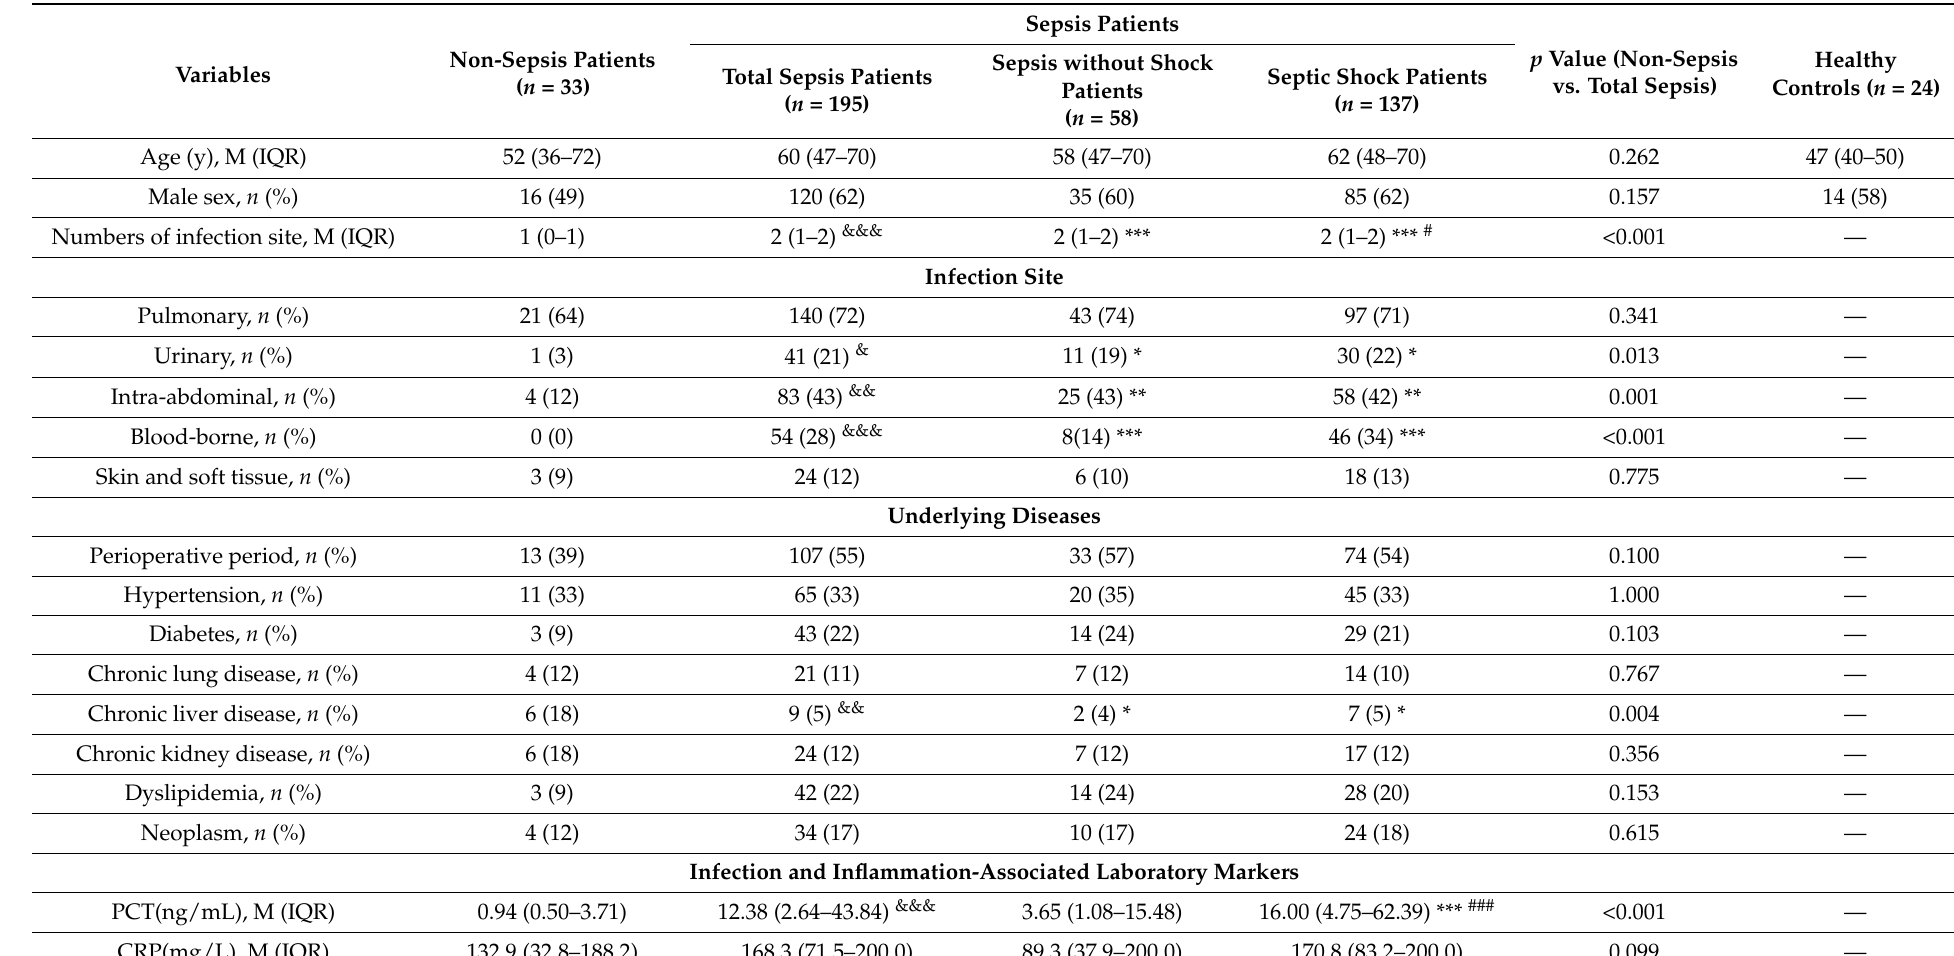
Table 1. Demographic, clinical, and laboratory characteristics of patients enrolled in the